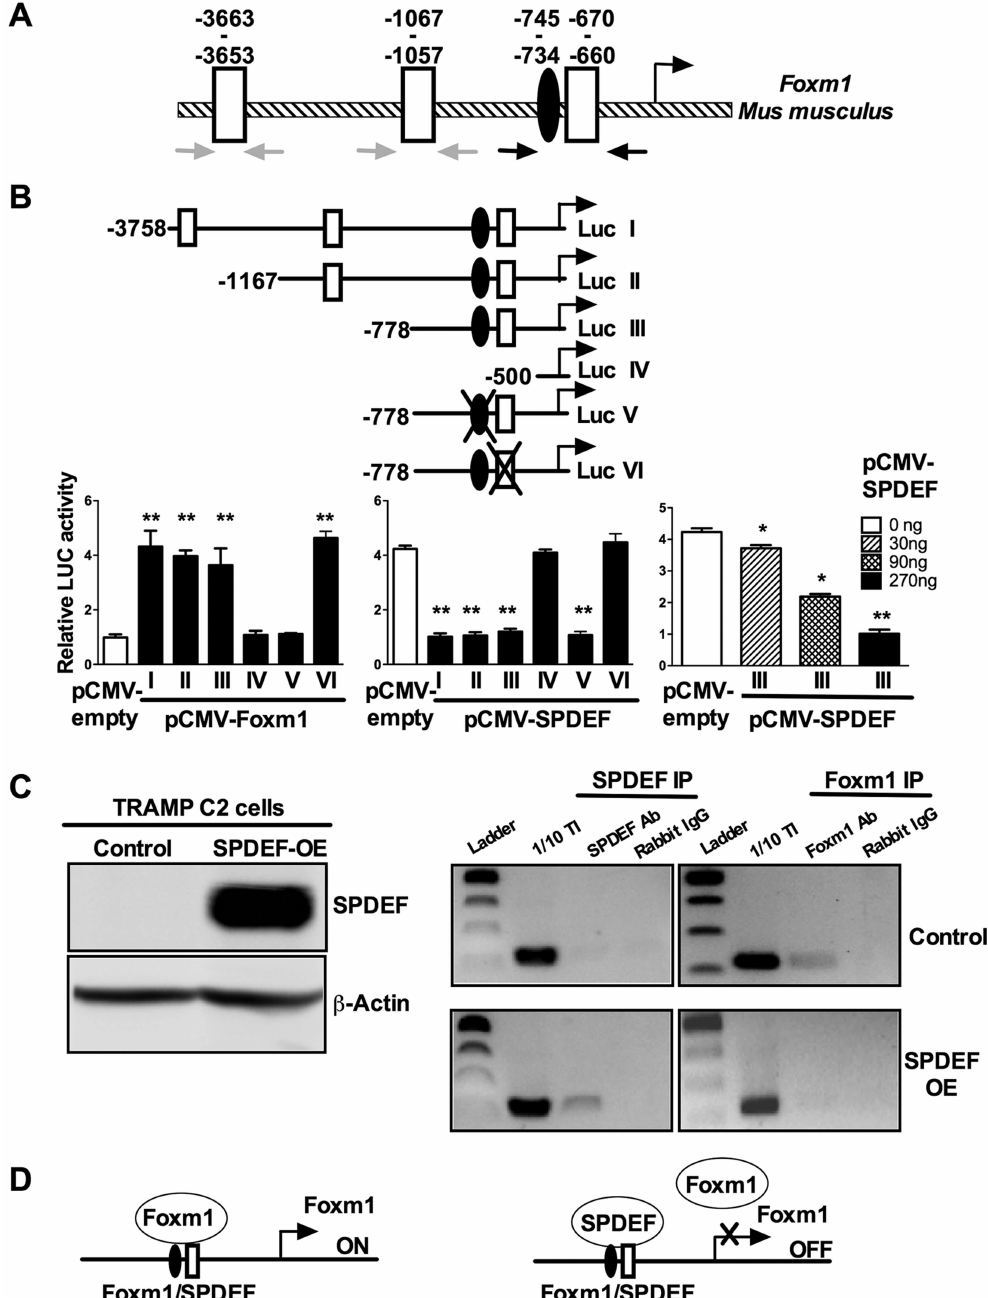
Figure 8. SPDEF represses the Foxm1 promoter. A . Schematic drawing of the mouse Foxm1 promoter shows the presence of an evolutionary conserved Foxm1 binding site (black oval) and three SPDEF binding sites (white boxes). B . Schematically shown the luciferase (Luc) reporter constructs: Luc I, includes the 2 3.7 Kb Foxm1 promoter region; Luc II-IV, include one of its deletion mutants; Luc V, includes a construct with mutations in Foxm1 site; Luc VI, includes a construct with mutations in SPDEF site. TRAMP C2 cells were transfected with CMV-Foxm1b or CMV-SPDEF expression vectors and one of the Foxm1 promoter LUC plasmids. CMV-empty plasmid was used as a control. Dual LUC assays were used to determine LUC activity. Transcriptional induction is shown as a fold change relative to CMV-empty vector ( 6 SD). A p value , 0.01 is shown with (**) and p value , 0.05 is shown with (*). C . Western blot shows efficient expression of SPDEF in TRAMP C2 cells after lentiviral transduction (left panel). ChIP assay was performed in control TRAMP C2 cells and TRAMP C2 cells overexpressing SPDEF (SPDEF OE). In control cell, Foxm1 is bound to its own 2 745/ 2 660 bp promoter region (Foxm1 IP). In SPDEF OE cells, SPDEF is bound to the 2 745/ 2 660 bp Foxm1 promoter region (SPDEF IP) and the binding of Foxm1 to this region is lost. Neither Foxm1, nor SPDEF bound to the 2 3663/ 2 3653 and to the 2 1067/ 2 1057 bp Foxm1 sites (grey arrows in A). D . Schematic drawing shows that SPDEF protein physically binds to the 2 745/ 2 660 bp Foxm1 promoter region and interferes with Foxm1 binding to the same region.